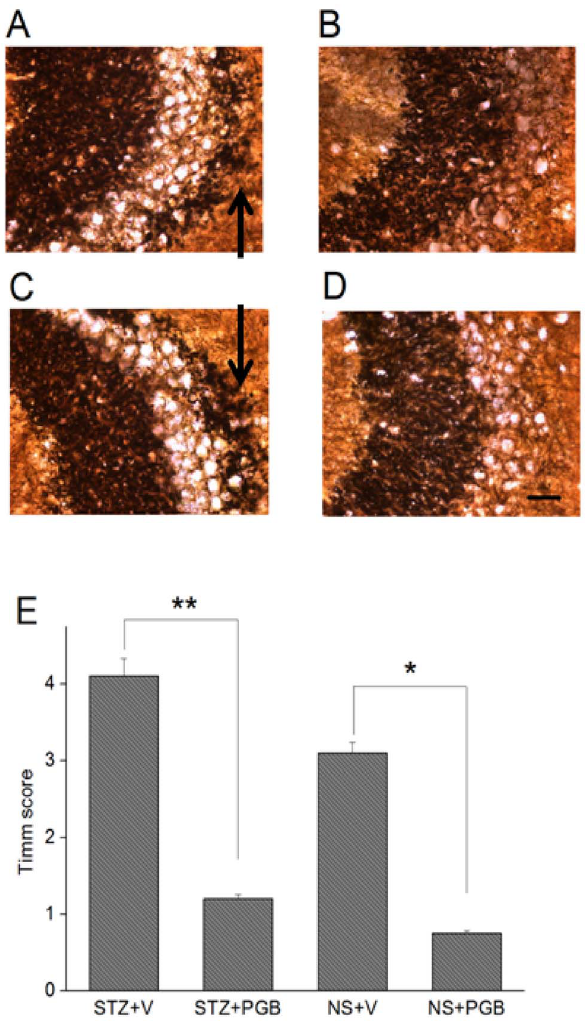
Figure 4. Mossy fiber sprouting in the post-status epilepticus chronic stage. There were more prominently Timm’s-stained fibers in the hippocampal CA3 area in A, the STZ + V group (strata pyramidale and oriens; arrow ), than in B, the STZ + PGB group. There were also more Timm’s-stained fibers in C, the NS + V group (strata pyramidale and oriens; arrow ), than in D, the NS + PGB group. E: The Timm’s score for the quantitative analysis of mossy fiber sprouting in the CA3 region was significantly higher in the STZ + V and NS + V groups than in the other two groups (STZ + V versus STZ + PGB, ** p , 0.01; NS + V versus NS + PGB, * p , 0.05) (ANOVA, n=5 in each group). The scale bar ( D ) represents